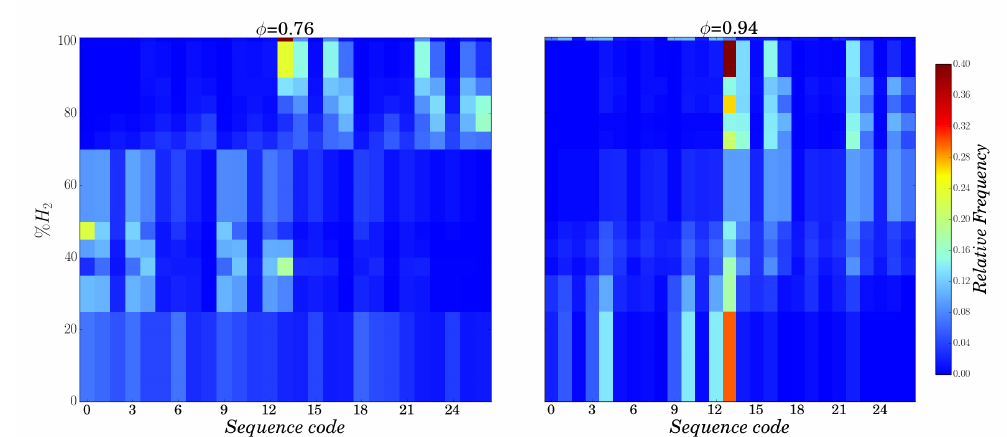
Figure 12. Color density plots of symbol sequence histograms of Q r for the cases shown in Figure